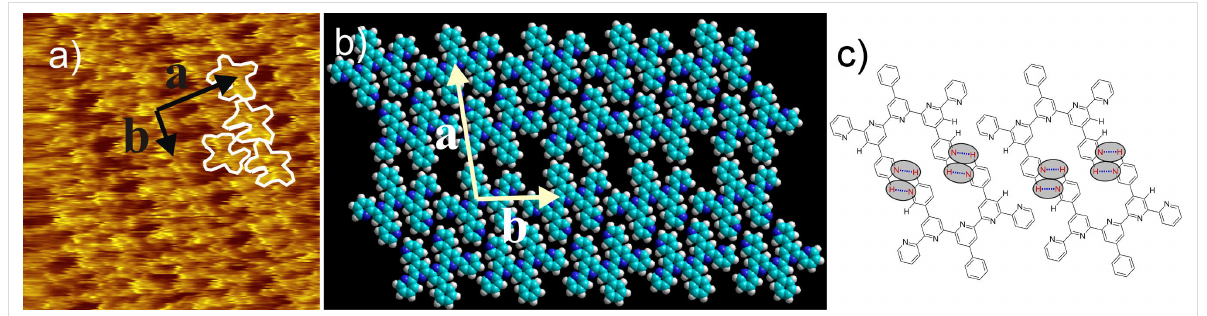
Figure 9: a) 16 × 16 nm 2 STM image ( I set = 2.1 nA, V set = − 0.60 V) of 2,3'-PhSpPy ( 13 ) at the HOPG/TCB interface [ a = 2.8 ± 0.1 nm, b = 1.5 ± 0.1 nm, a,b = 93 ± 2°] with four overlaid molecules; b) model of the 2,3'-PhSpPy ( 13 ) lamellar pattern; c) hydrogen bonding motif of 2,3'-PhSpPy ( 13 ); the hydrogen bonds are marked by ovals.